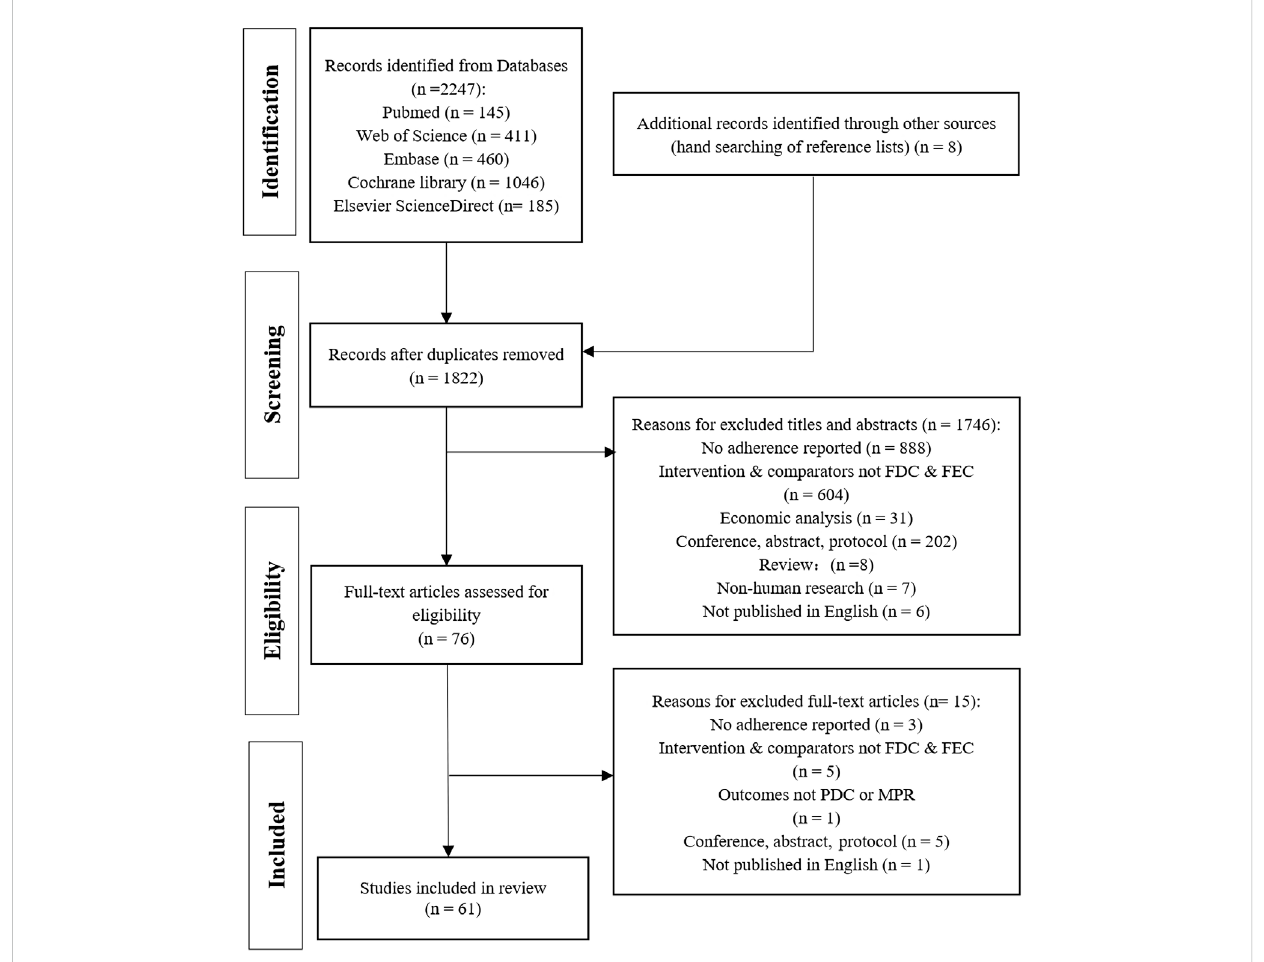
PRISMA fl ow diagram for study selection process. FDC: fi xed-dose combination; FEC: free-equivalent